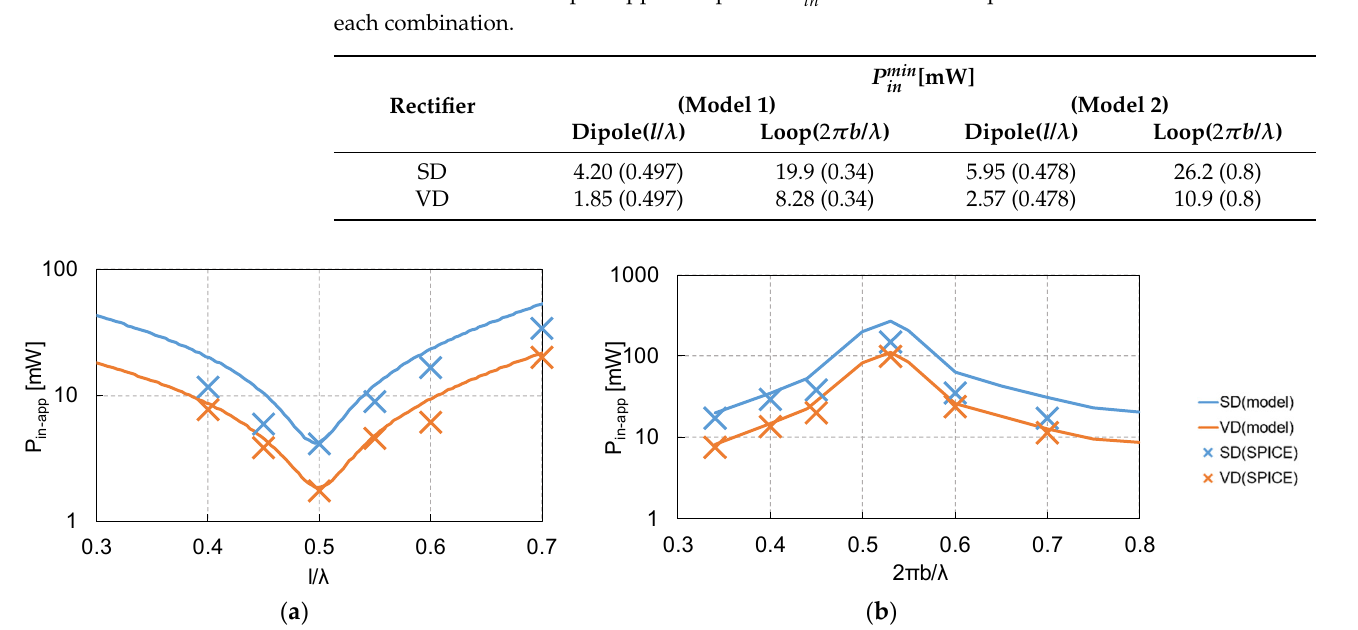
Figure 15. Antenna parameter vs. P in − app based on model 1 at P out = 100 µ W ( 1 V, 100 µ A ) : ( a ) dipole antenna, ( b ) circular loop antenna.